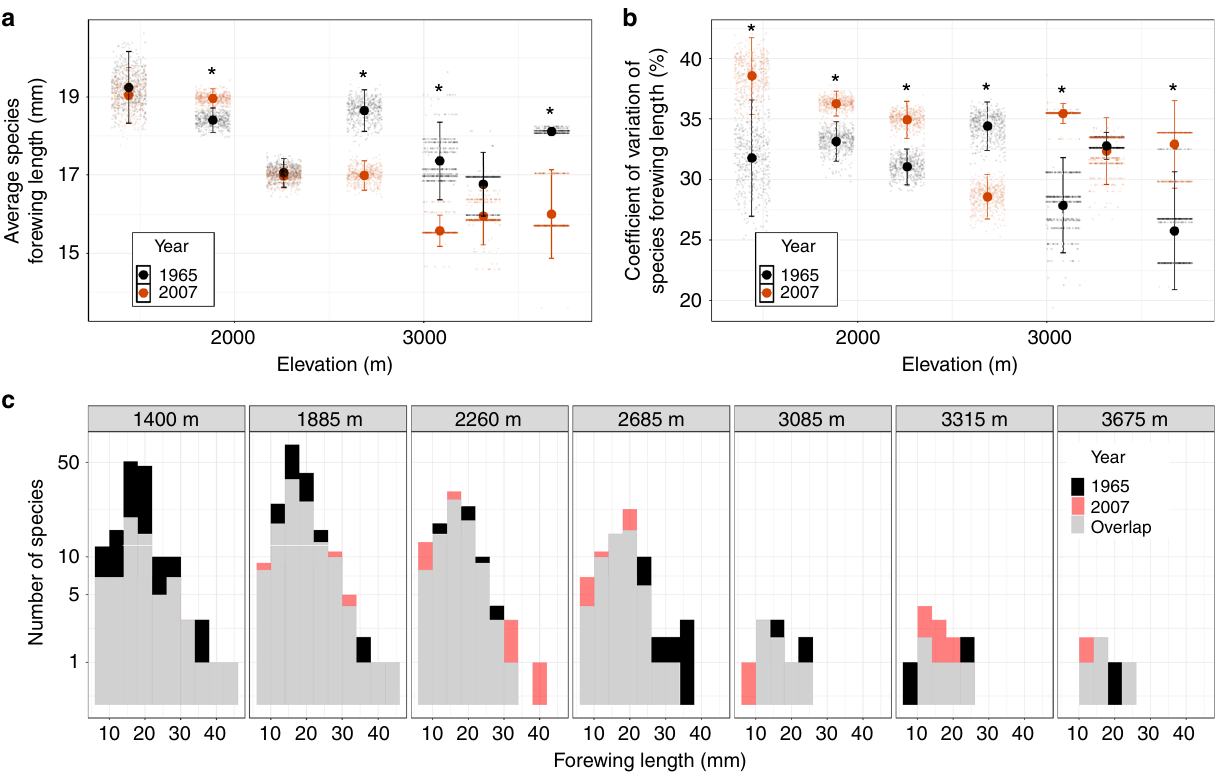
Fig. 1 Moth assemblage size structure in 1965 (black) and 2007 (red). a Average species forewing length (mm). b Coef fi cient of variation of species forewing length. c Frequency distribution of species forewing length. In ( a ) and ( b ), mean and 95% con fi dence interval at each site are shown, based on 500 resamples. Data points are overlaid. Asterisks indicate signi fi cant ( p < 0.05) differences between 1965 and 2007. In ( c ), the number of species are on log10 scale and overlaps between the 2 years are illustrated in